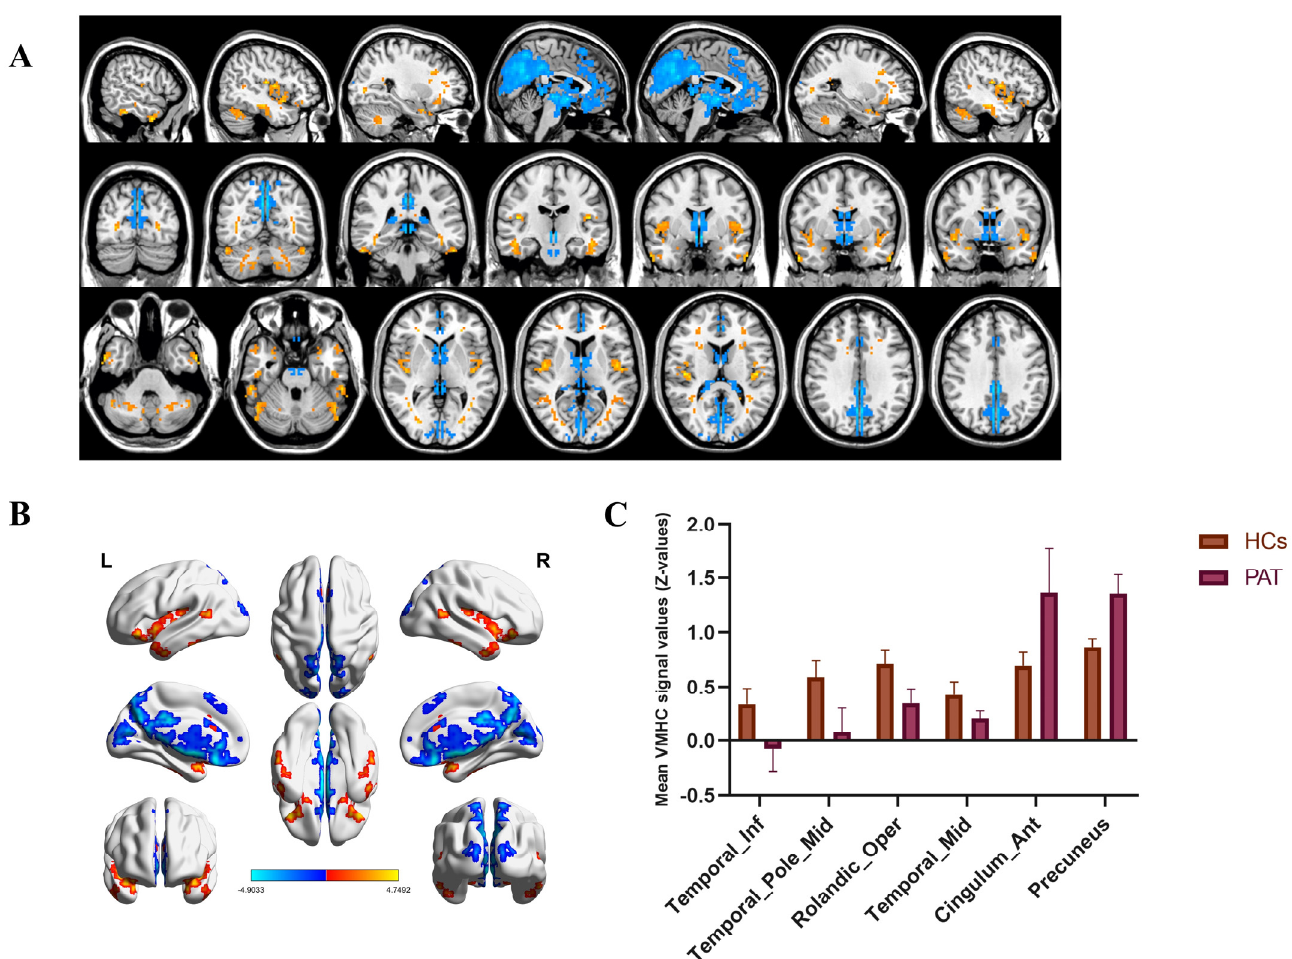
Figure 4. The results of VMHC analysis. Notes: The areas of the brain that show altered VMHC values are labelled on the figure. In ( A ) and ( B ), red indicates that the PAT group exhibited higher VMHC values than the HCs and the decrease in VMHC values is indicated in blue. The results of the measurement of VMHC values between the two groups, as represented by the bar chart, are presented in ( C ). Abbreviations: HCs, healthy controls; PAT,